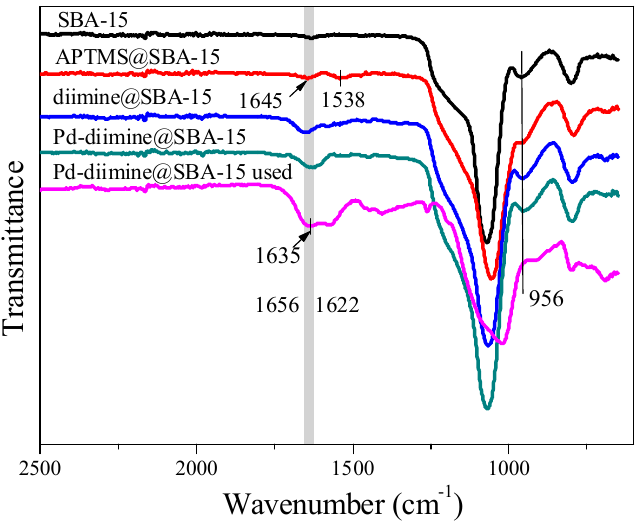
Figure 1. Fourier ‐ transform infrared (FT ‐ IR) spectra of SBA ‐ 15, 3 ‐ aminopropyl trimethoxysilane (APTMS)@SBA ‐ 15, diimine@SBA ‐ 15, and Pd ‐ diimine@SBA ‐ 15 (fresh and used repeatedly four times).